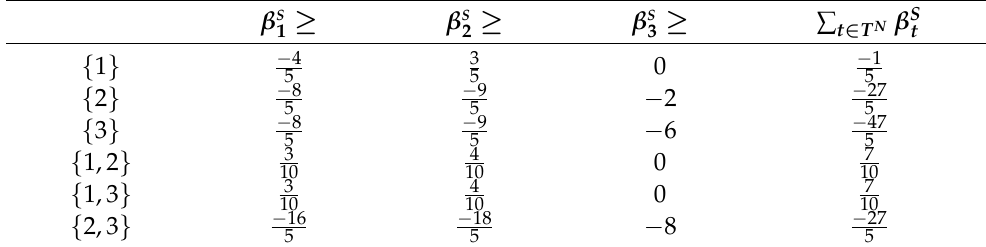
Table 6. Weights associated to the optimal